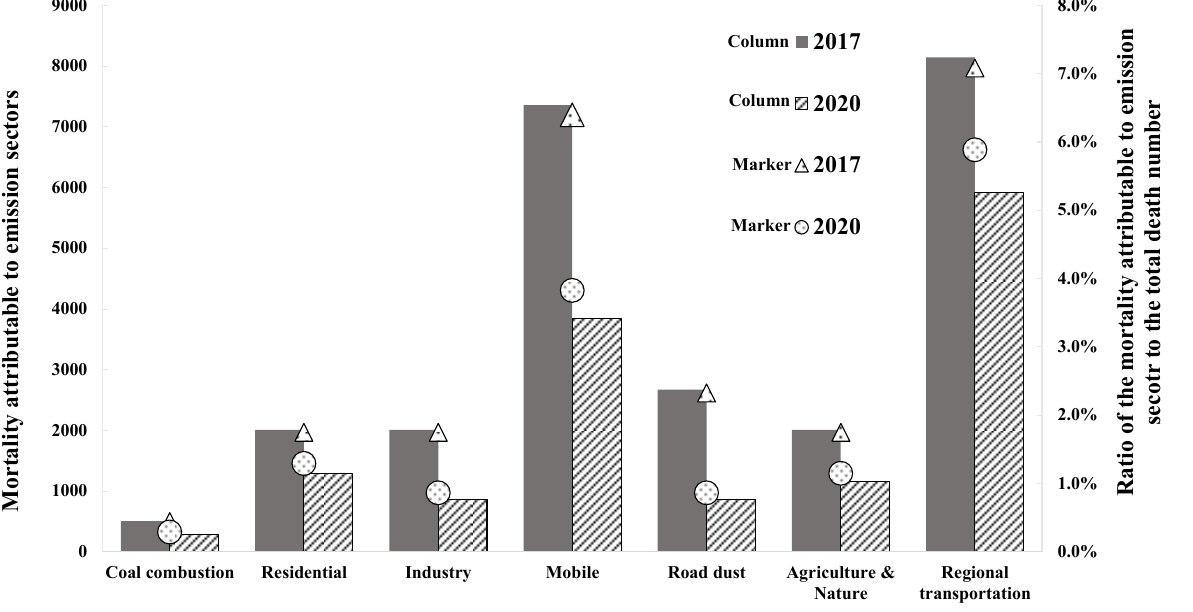
Figure 9. Comparison of the mortality attributable to each emission sector of PM 2.5 (left axis) and the ratio of the mortality attributable to emission sectors to the total number of deaths in Beijing (right axis) between 2017 and 2020.